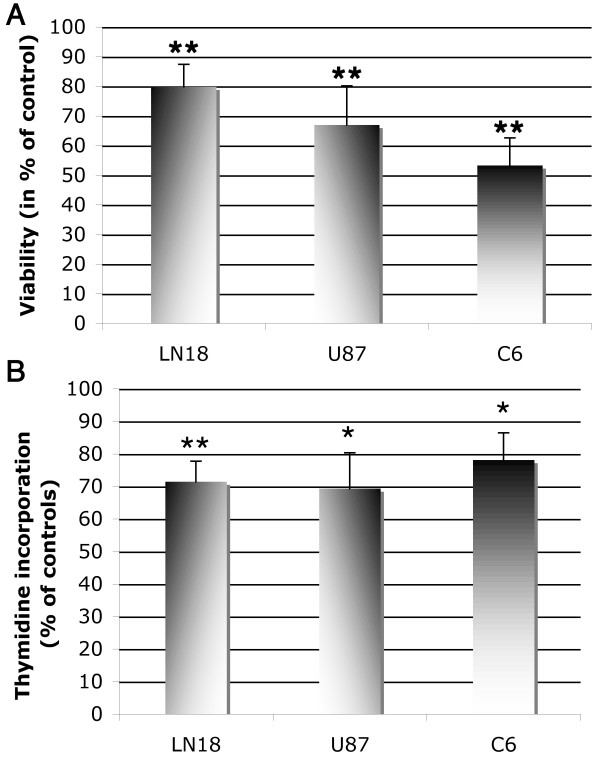
Cell growth and thymidine incorporation. (A) The total viability of LN18, U87 and C6 cells grown for 5 days with 1 μM dexamethasone (DEX) was determined by way of an MTT test. For each condition, the viability in the absence of DEX was set as 100 percents (n = 3, mean ± SD). (B) The incorporation of 3H-thymidine in LN18, U87 and C6 cells grown for 48 hours in the presence of DEX is shown (n = 3, mean ± SD). For each condition, the incorporation in the absence of DEX was set as 100 percents. (*: P < 0.05; ** P < 0.005, Student's t-test).